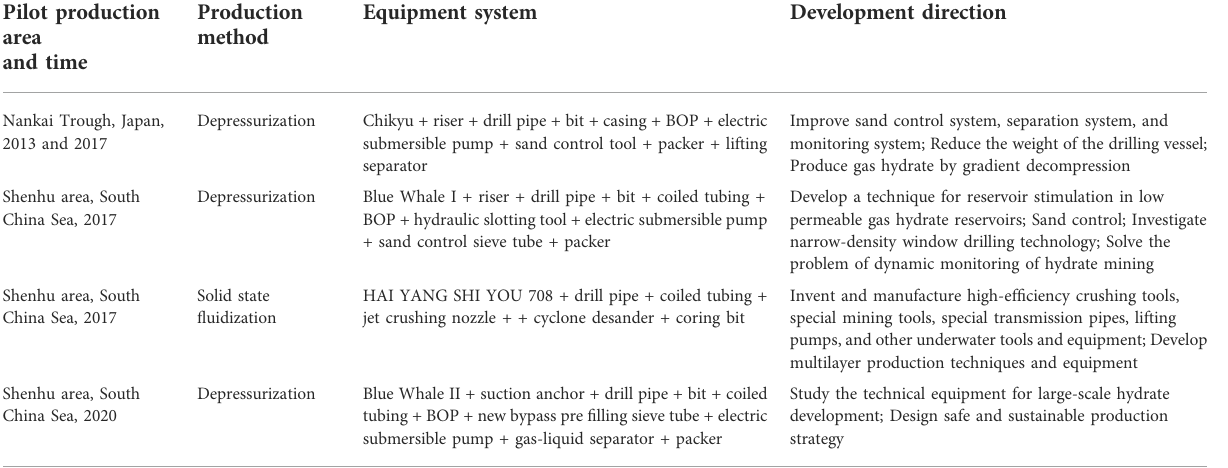
TABLE 6 Typical equipment system for gas hydrate drilling [modi fi ed from 186]. Pilot production